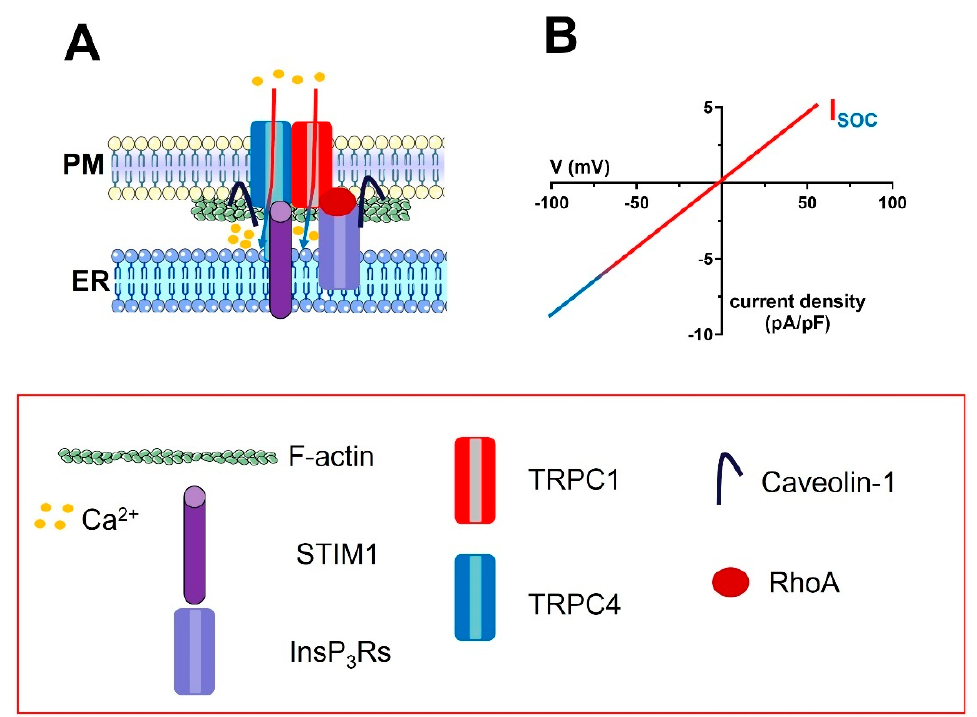
Figure 3. The molecular architecture of the I SOC in vascular endothelial cells. ( A ), the endothelial I SOC is mediated by a complex ion channel signalplex that is located on plasmalemmal caveolae. The ion channel pore is contributed by TRPC1 and TRPC4 channels, which are informed about changes in [Ca 2+ ] ER by STIM1. The signalling microdomain is enriched with InsP 3 Rs, which interact with the TRPC1 and TRPC4 subunits via caveolin-1. For sake of clarity, only the interaction between InsP 3 Rs and TRPC1 has been shown. The monomeric GTP − binding protein, RhoA, also supports the interaction between InsP 3 Rs and TRPC1 via F − actin polymerization (two bundles of F-actin were drawn beneath the plasma membrane). ( B ), the IV relationship of the endothelial I SOC